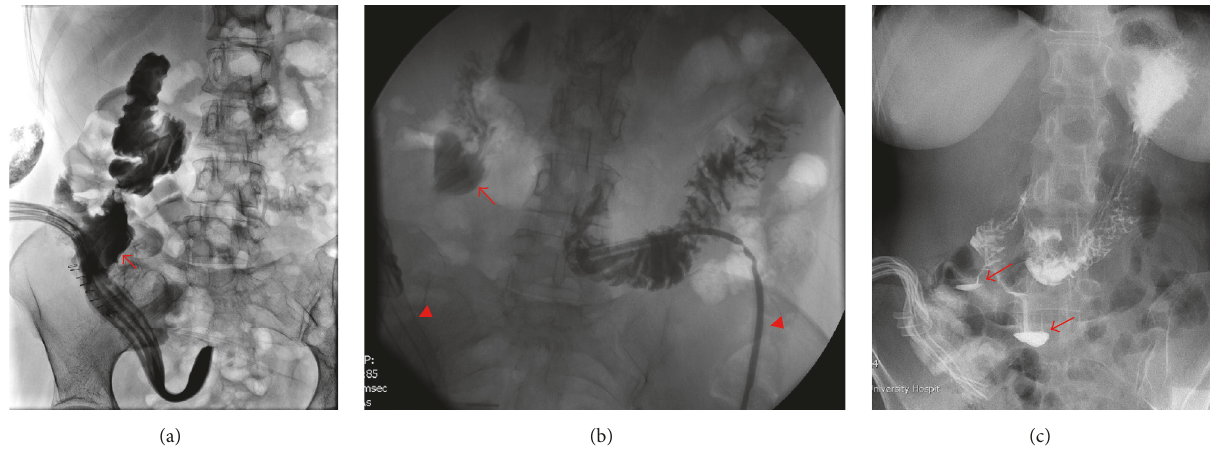
Figure 2: (a) Drainogram showing a fistulous tract (arrow) between the retroperitoneal cavity and the duodenum, secondary to a perforated duodenal diverticulum. (b) Gastrografin swallow fluoroscopy, upon follow-up, with absence of any contrast extravasation from within the duodenal diverticulum (arrow). Note the jejunostomy feeding tube and the retroperitoneal drain in place (arrow heads). (c) Layering of contrast, during a gastrografin swallow, into two duodenal diverticula (arrows), without any contrast extravasation, seen upon